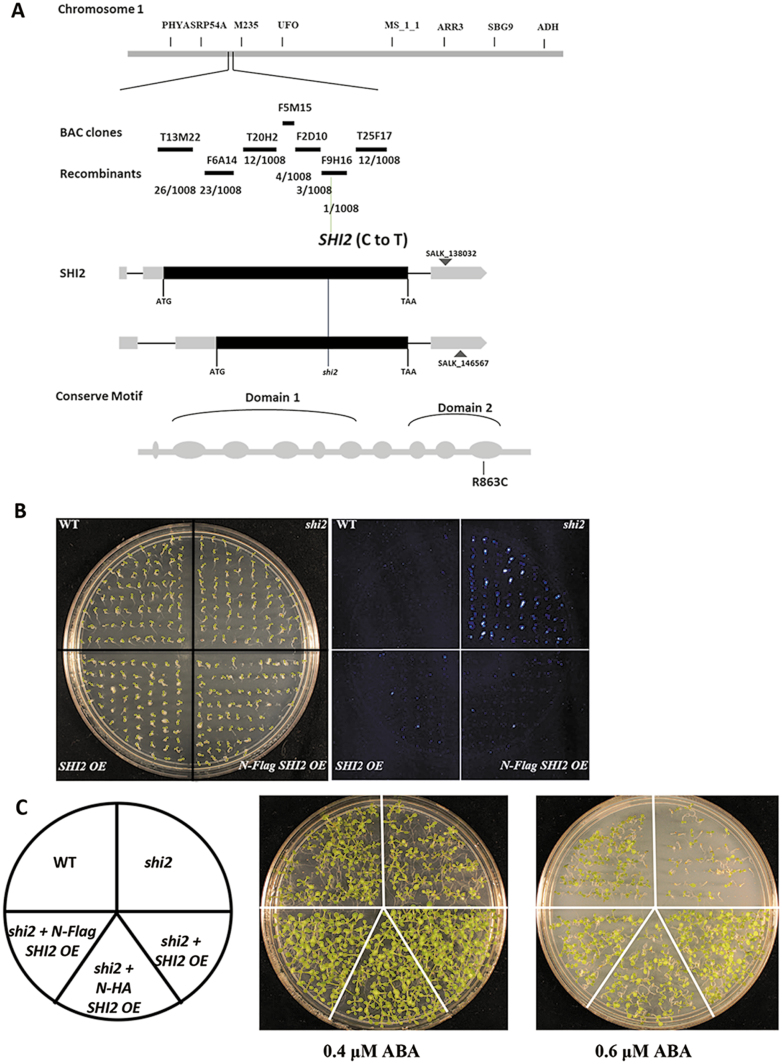
Map-based cloning and complementation of the shi2 mutant. (A) Map-based cloning of the SHI2 locus. A change of C to T at nucleotide position 2587 and its resulting amino acid substitution in the shi2 mutant are shown. (B) Molecular complementation of the shi2 mutant by the wild-type SHI2 gene. A bright field image of seedlings grown on a 1/2 MS plate is shown in the left panel and the corresponding bioluminescence image is shown in the right panel. (C) Complementation of the shi2 mutant by overexpression of SHI2. Seeds were plated for germination assay with 0.4 µM and 0.6 µM ABA, and photographs were taken after 14 d. (This figure is available in color at JXB online.)